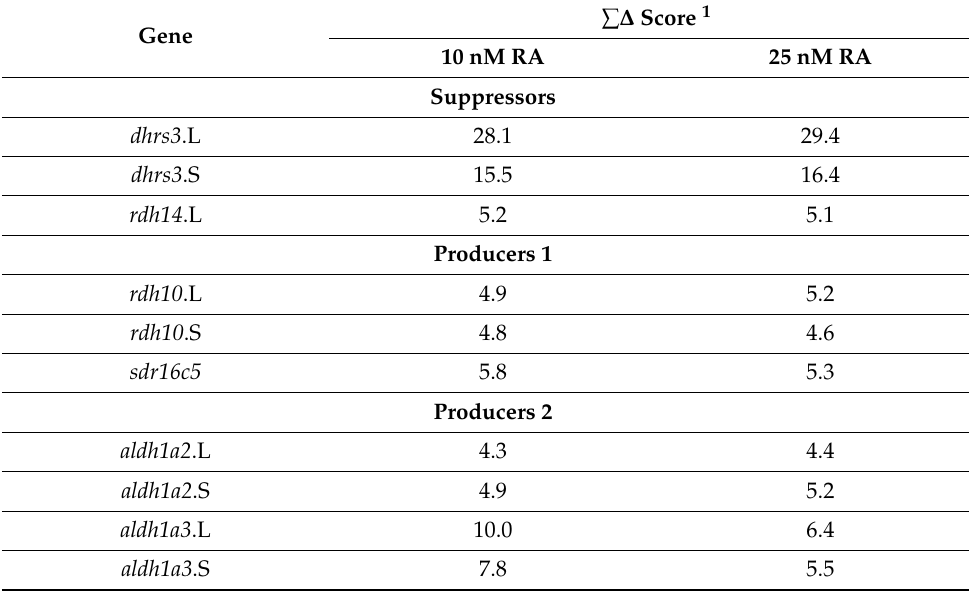
Table 4. Regulation tightness score for the RA network homoeologs and